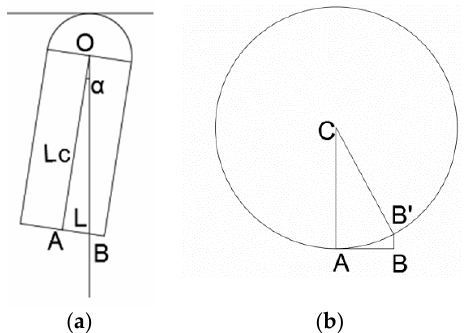
Figure 13. The geometric relationship between arc 𝑨𝑩 ′ and the deflection angle 𝜶 . ( a ) is the side view of Figure 12 and ( b ) is the top view of Figure 12. In practical experiments, the line OB is indicated by a tied hammer.